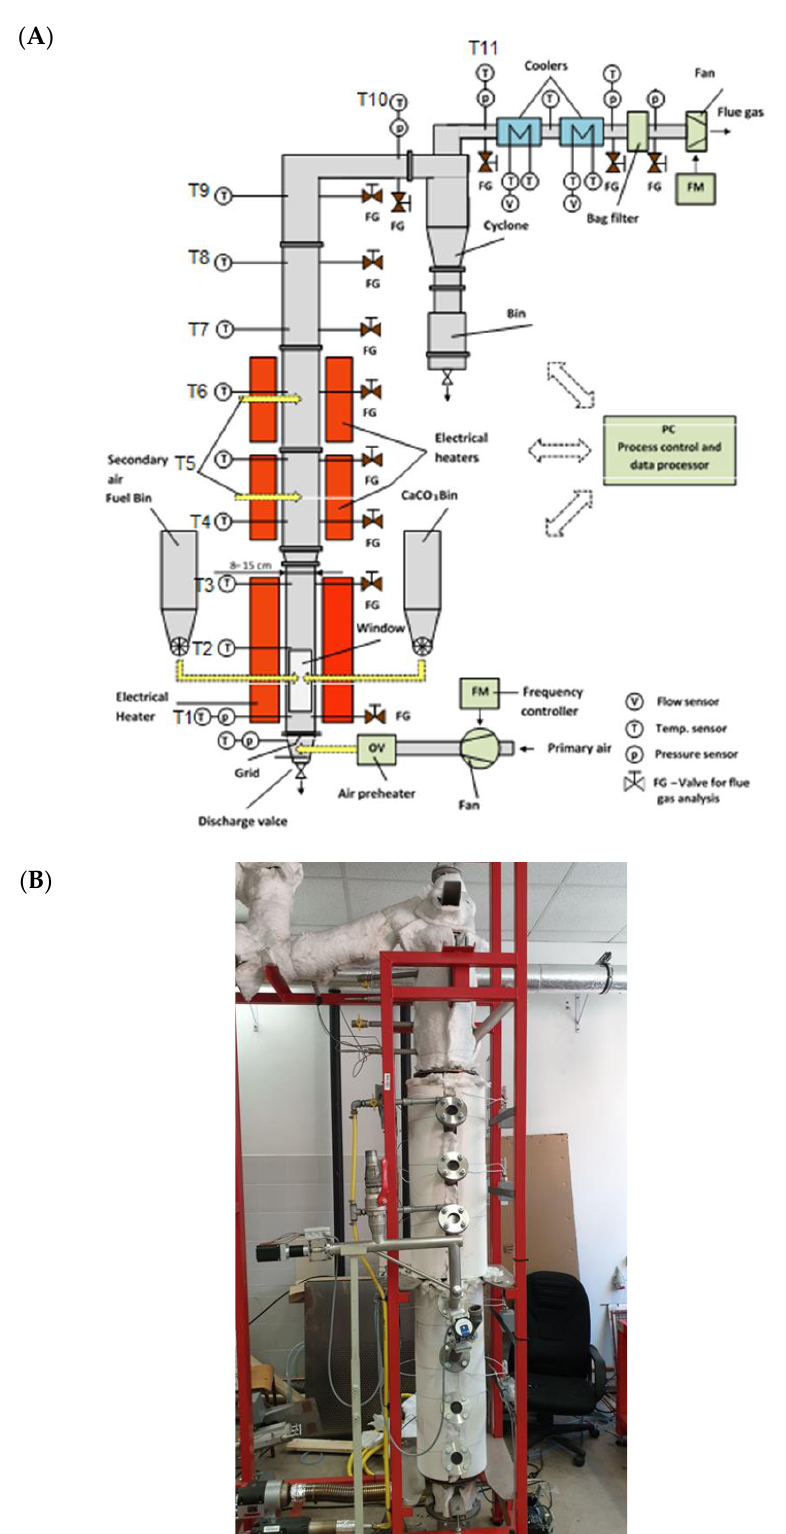
Figure 1. Scheme ( A ) and photo ( B ) of the experimental unit. Distance of temperature sensors from the grid: T1 120 mm, T2 320 mm, T3 520 mm, T4 720 mm, T5 920 mm, T6 1120 mm, T7 1320 mm, T8 1520 mm, T9 1720 mm, T10 1920mm, and T11 2120